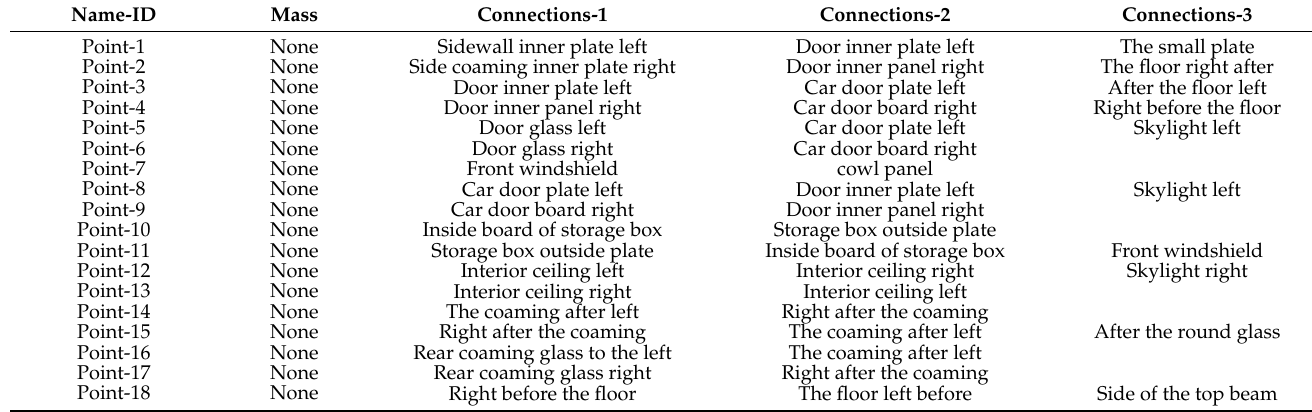
Figure 4. All connections of the commercial vehicle cab. ( a ) All point-wire connection model; ( b ) All connection model. Table 2. Part of the point connection model.